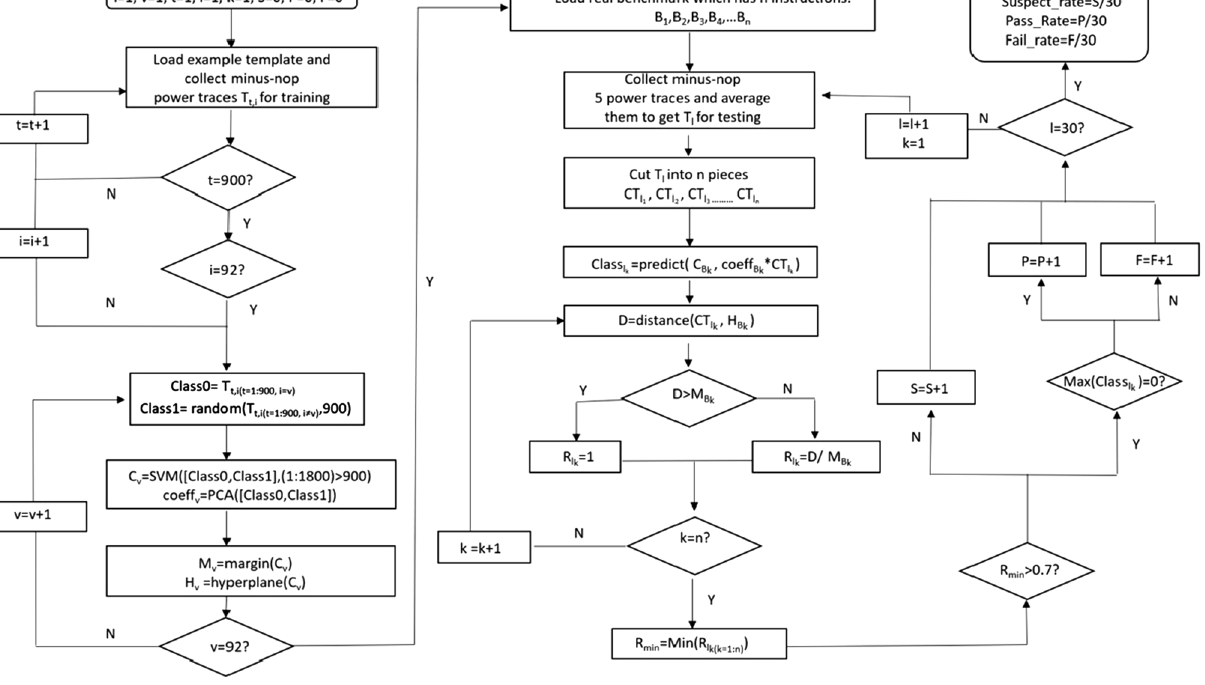
Fig. 7 Flow chart of the verification methodology and application in